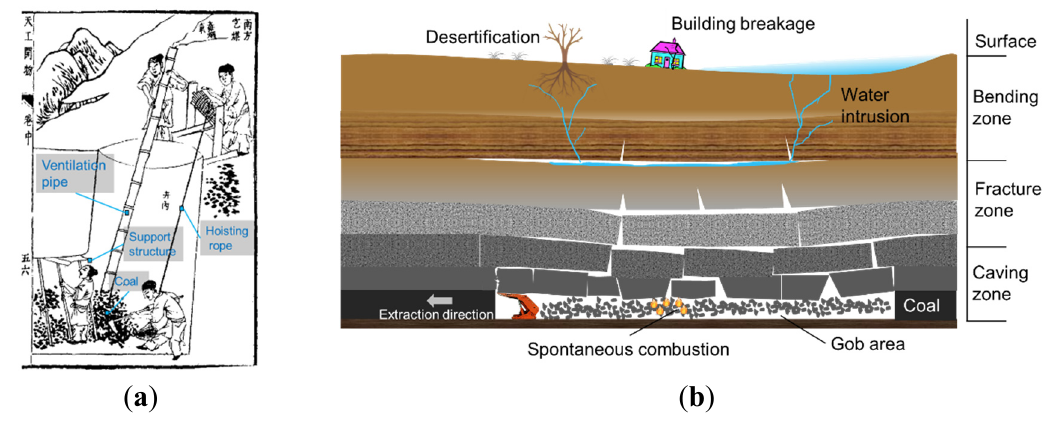
Figure 2. Comparison of an ancient mining method and current mechanised mining without backfilling. ( a ) The ancient mining method described in The Tiangong Kaiwu , published in 1637; ( b ) The current mechanised mining method; the method is characterised by its caving system, which is both economical and efficient to enable high